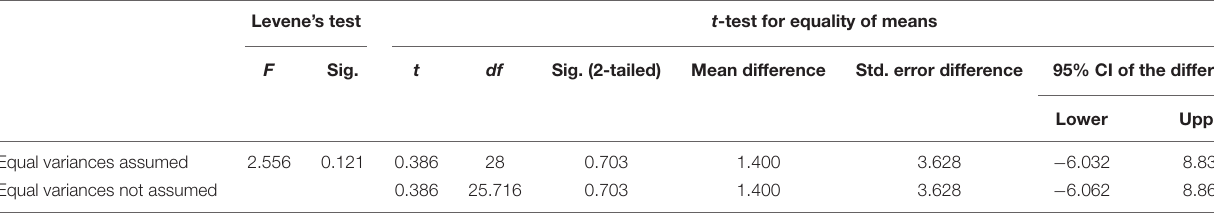
TABLE 2 | Independent samples t -test results for baseline measures of the two treatment groups.